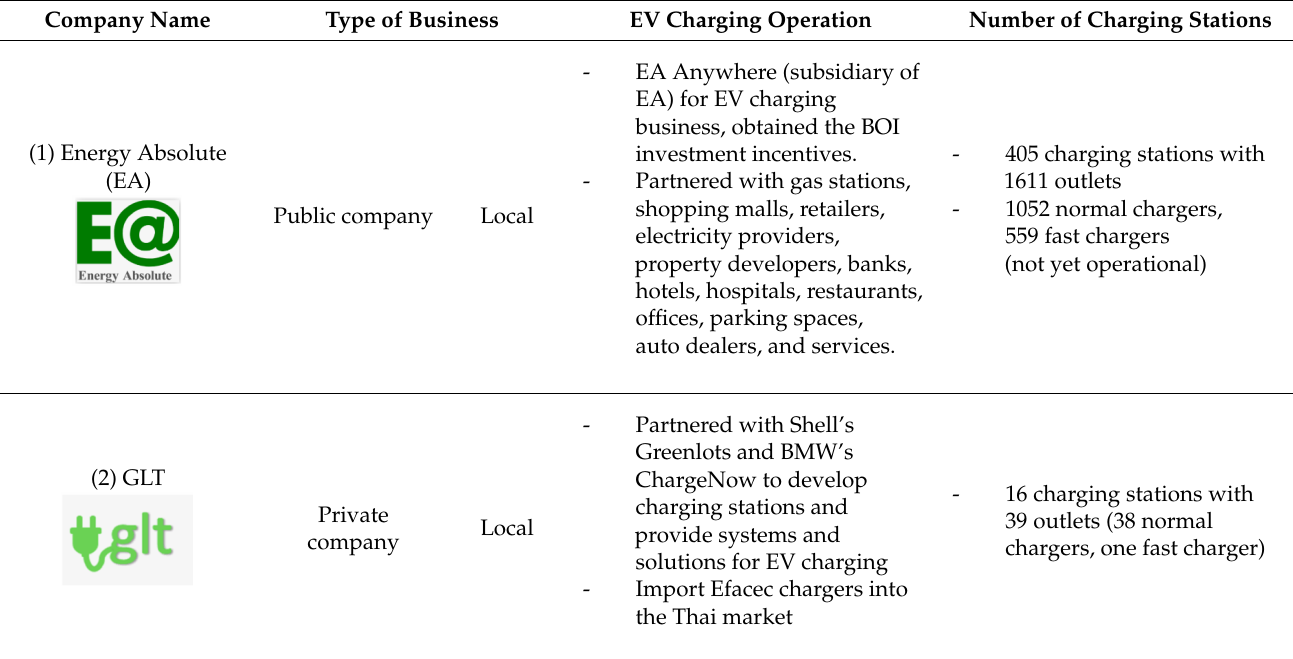
Table 6. EV charging operations of green energy